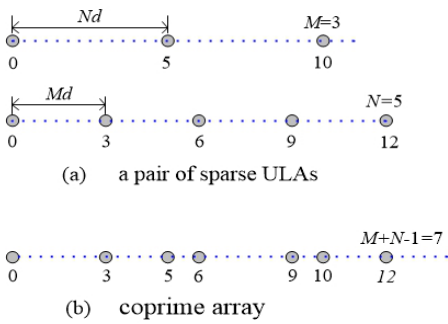
Figure 1. The structure of coprime array with M = 3 and N =